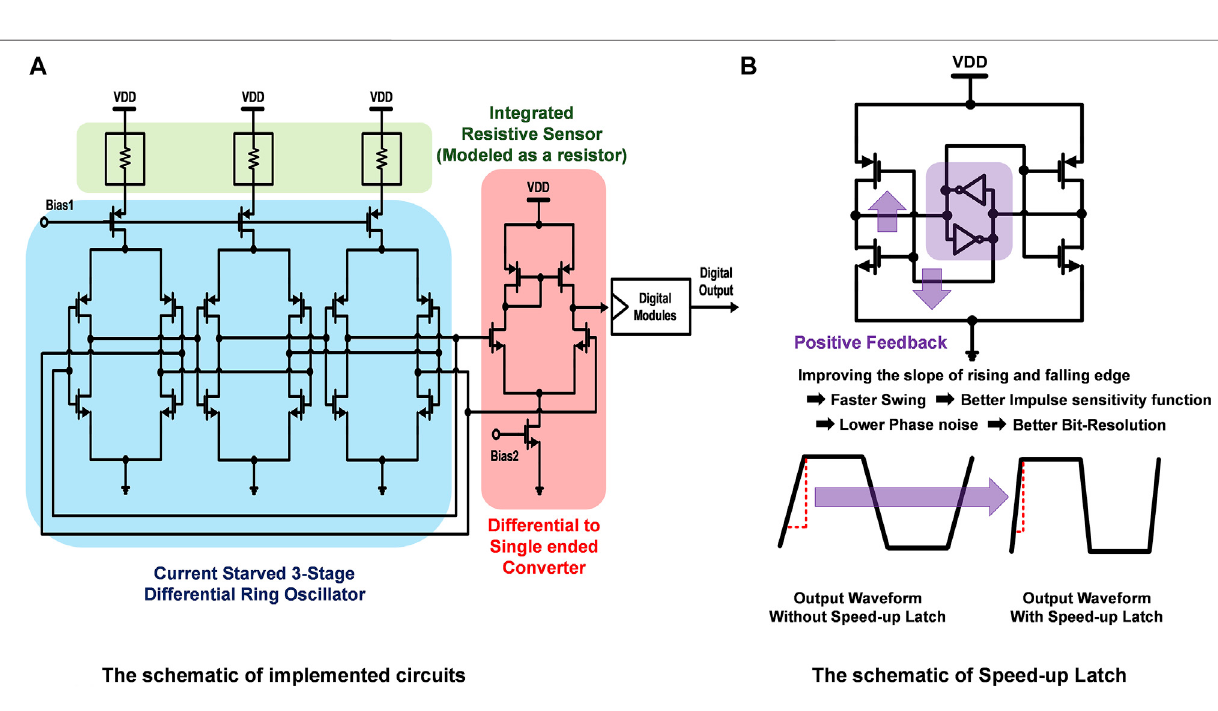
Frontiers in Electronics |